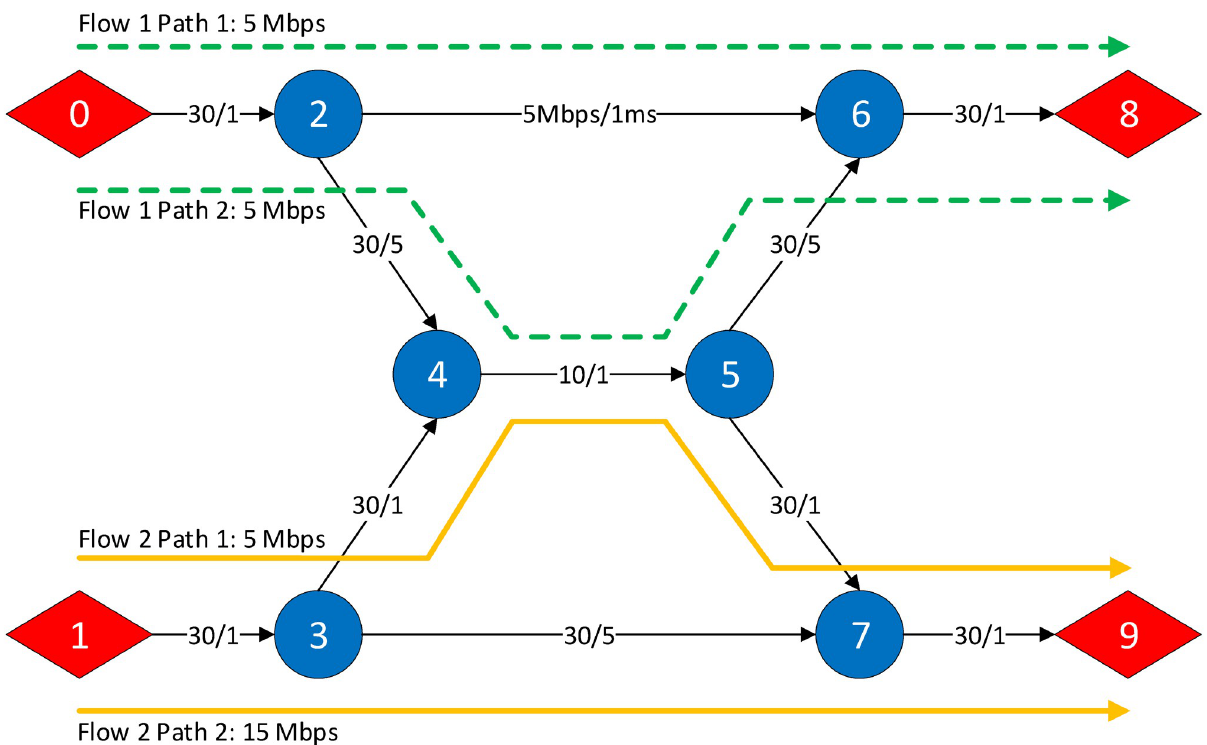
Fig 3. Butterfly network used to explain the chromosome representation of a network. Flows 1 and 2 are transmitting at a data rate of 10 Mbps and 20 Mbps respectively. Each flow is allowed to transmit on two paths, as shown by the green and yellow path markers